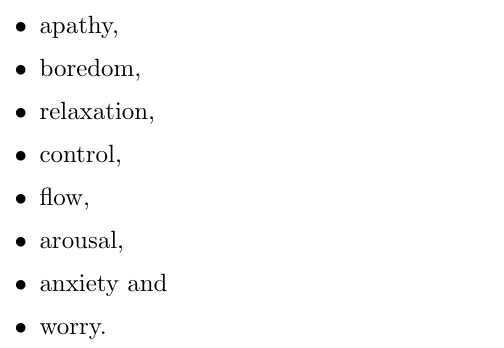
Figure 11: Flow Condition findings by user feelings (FGUI) the flow model. A ”heat map” is also included which indicates the frequency of answers in the regions. Answers are spread throughout the graphs indicating that none of the user interfaces were able to induce a narrow field of emotions. The most frequent answer on both TGUI and FGUI was the feel of